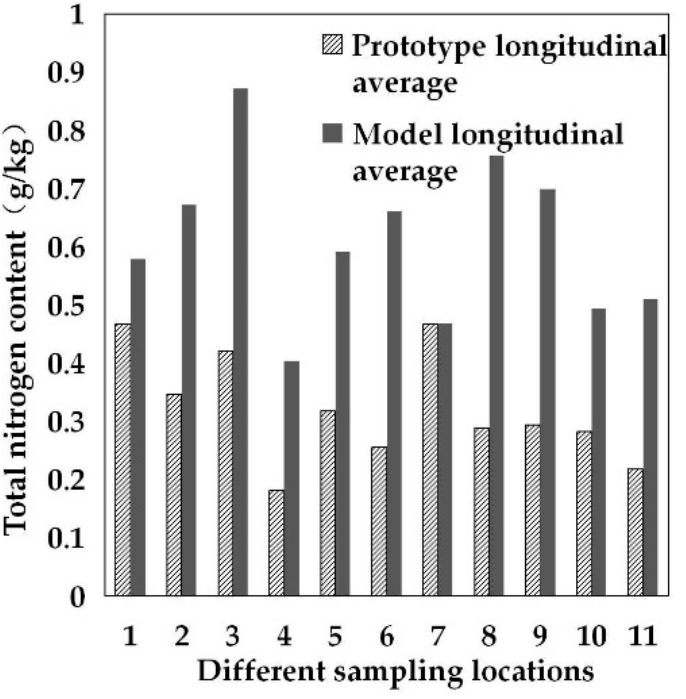
Figure 8. Total nitrogen content at each sampling point for the prototype and model of the small watershed.